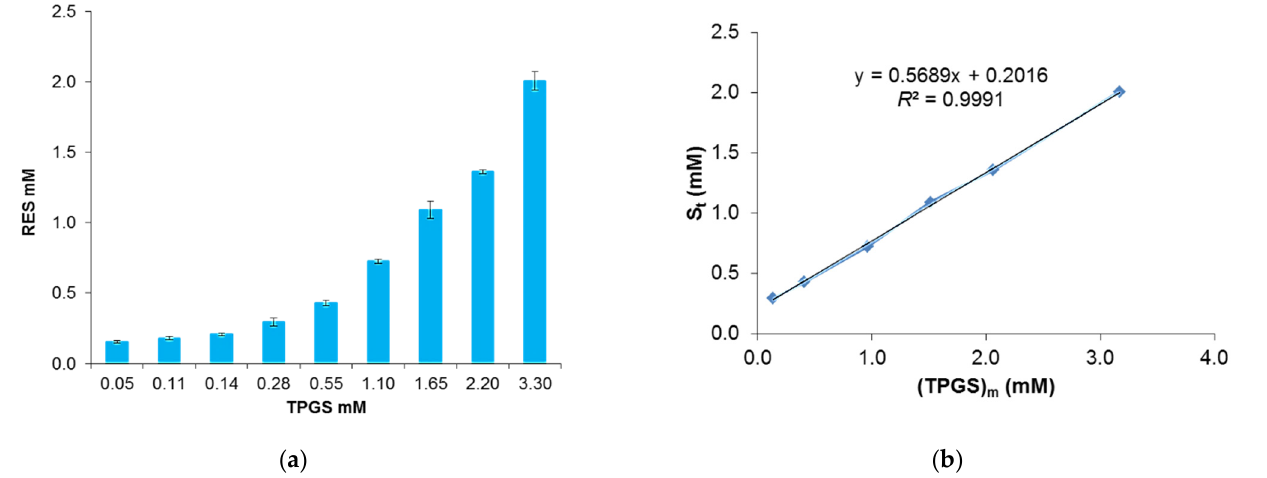
Figure 2. TPGS concentration-dependent solubility of RES. Total solubility of RES versus TPGS concentration, measured using the equilibrium method after 48 h at 37 °C in water ( a ); linear regression obtained considering the values above the TPGS CMC ( b ).